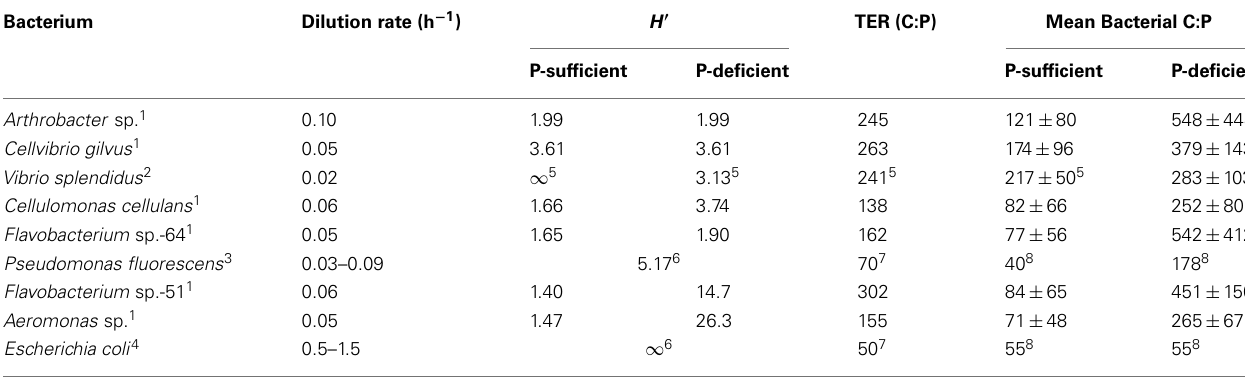
Table 1 | Chemostat dilution rates with defined media, homeostasis values ( H (cid:3) = 1/ m where m is the slope of the resource C:P versus bacterial C:P in log–log space) for P-sufficient and P-deficient cultures, and estimated C:P threshold element ratios (TER) for various heterotrophic